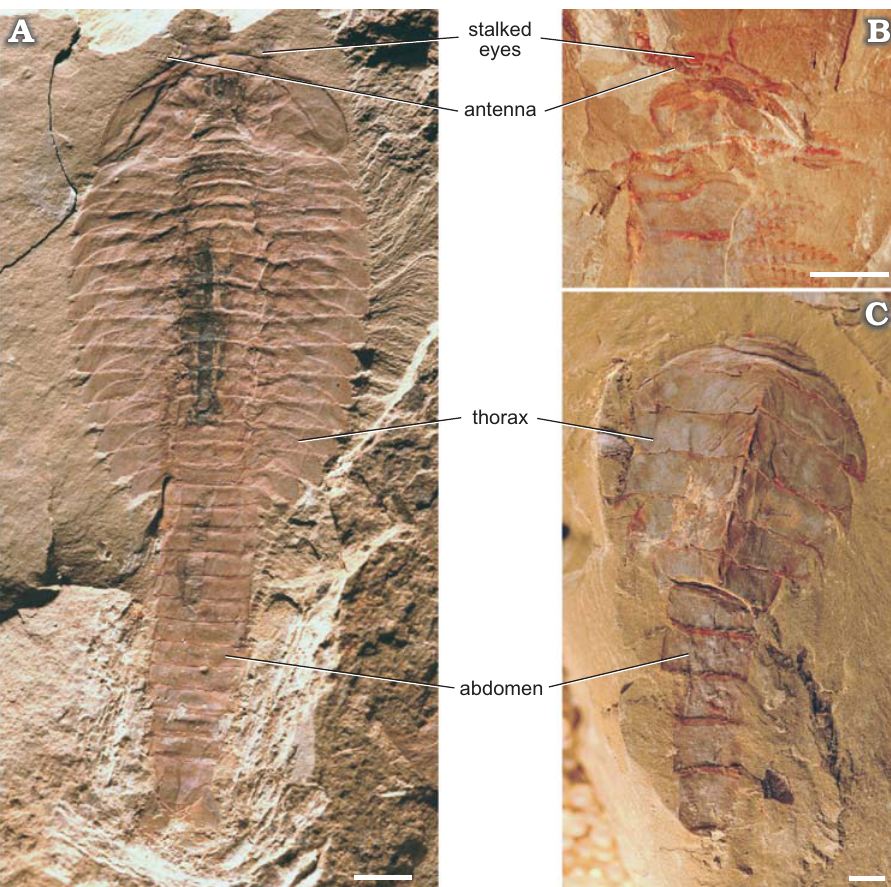
Fig. 3. The comparison of fuxianhuiid euarthropods Fuxianhuia protensa Hou, 1987 from Chengjiang Biota, Cambrian Series 2, Stage 3, Yunnan, China (A) and Guangweicaris spinatus Luo, Fu, and Hu, 2007 from Guanshan Biota, Cambrian Series 2, Stage 4, Yunnan, China (B, C). A . EJ0072A in dorsal-ven- tral view, showing the typical F. protensa body. B . ELI-LBSG-0046A in lateral view, showing the whole head part and the pairs of thoracic appendages of Guangweicaris . C . ELI-LBSG-0003 in dorsal-ventral view, showing the typical Guangweicaris thorax and abdomena parts. Scale bars 5